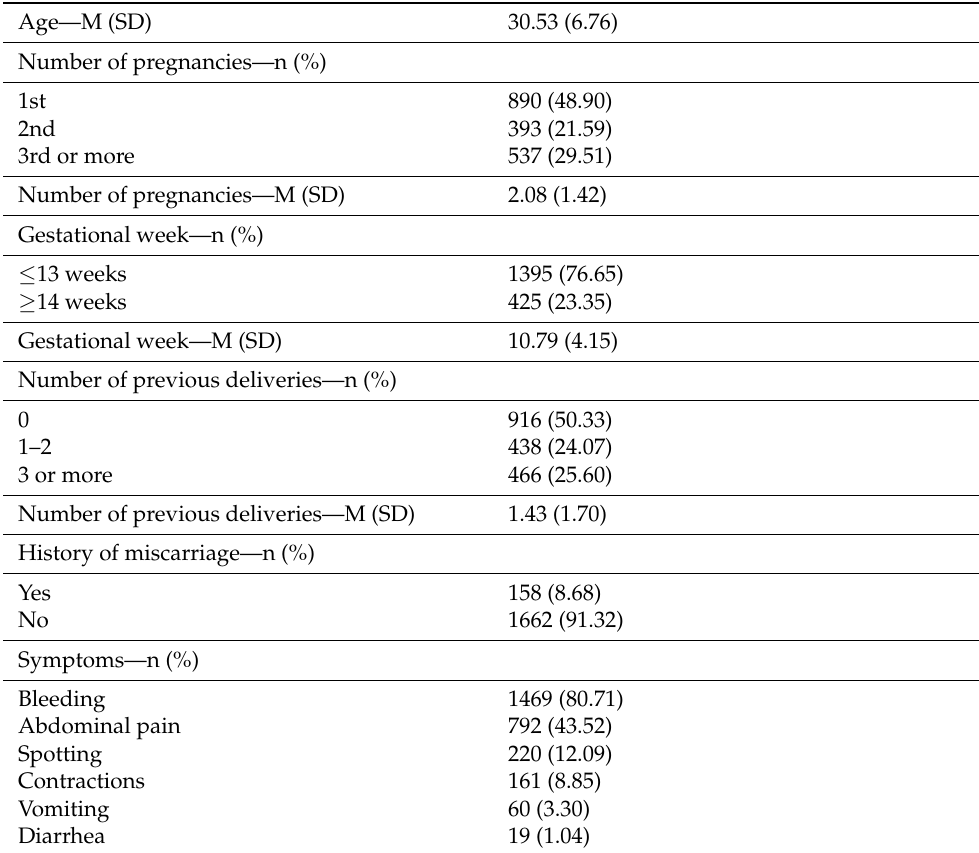
Table 1. Characteristics of the women with suspected